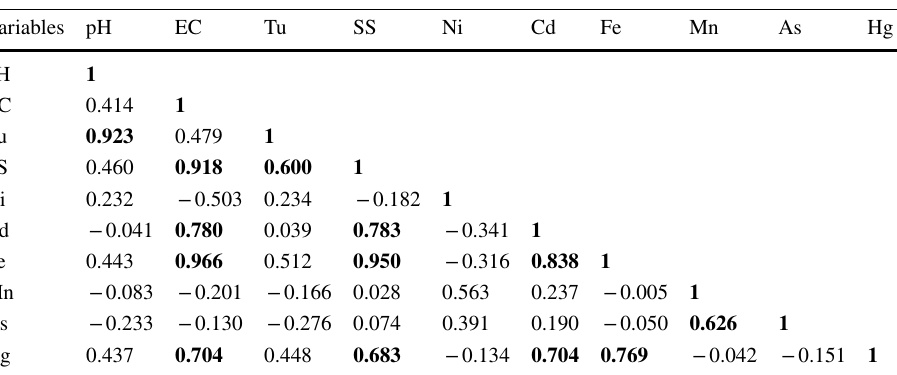
Bold values indicate strong correlations between variables pH Potential Hydrogen; EC Electrical Conductivity; Tu Turbidity; SS Suspended solids; Ni Nickel; Cd Cadmium; Fe Iron; Mn Manganese; As Arsenic; Hg